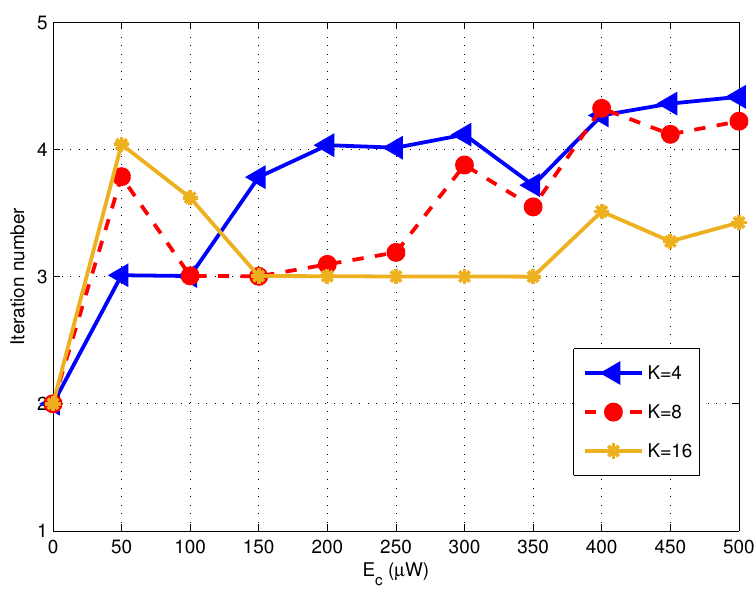
Figure 8. Iteration number needed for the proposed algorithm ( σ 2 = − 112 dBm K = 4 ,8 ,16 and BER targets = 10 − 6